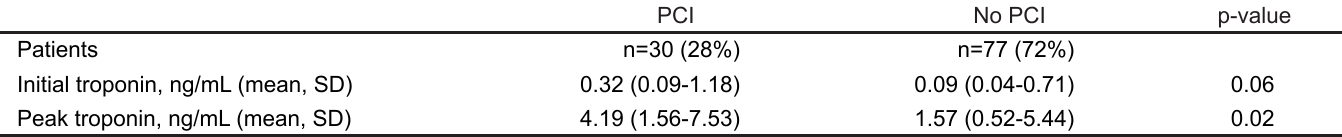
Table 2. Association with initial and peak troponin with percutaneous coronary intervention